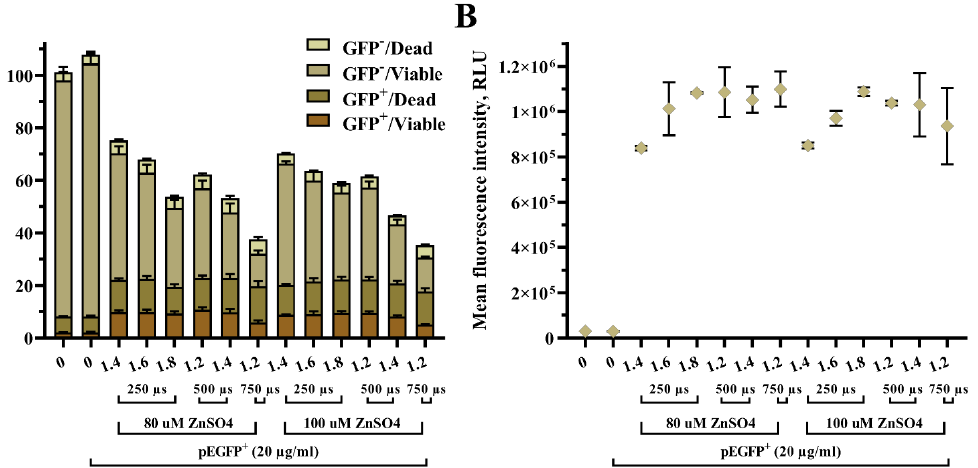
Figure 4. The effect of ZnSO 4 for pEGFP GET efficiency in UT-7 cells under varying pulse strengths (kV/cm- X-axis) and pulse duration ( µ s), where transfected/viable cells denoted as (GFP + /Viable), transfected/dead as (GFP + /Dead), untransfected/viable as (GFP - /Viable), and untransfected/dead as (GFP - /Dead) shown in stacked bars. The overall cell number in the sample is shown as column height ( A ). The pEGFP fluorescence intensity is represented by a scatter dot plot ( B ). The data points are shown as mean ± SD from two independent experiments performed in quadruplicate and were further analyzed using one-way ANOVA with Tukey’s multiple comparisons test. All statistical results are presented in the Supplementary file (Table S2). ZnSO 4 acts as an inhibitor of intracellular nucleases and potentially can prevent plas- mid degradation after plasmid DNA entry into the cell. However, we determined no sup- plementary effect of ZnSO 4 on pEGFP GET efficiency in suspension UT-7 cells. For in- stance, the overall cell number decreased according to pulse intensity and duration. Here, the subpopulation number in transfected/viable cells remained the same under different EP parameters and varying ZnSO 4 concentrations (Figure 4A). No significant changes in the mean fluorescence intensity were observed when comparing two different ZnSO 4 con- centrations.